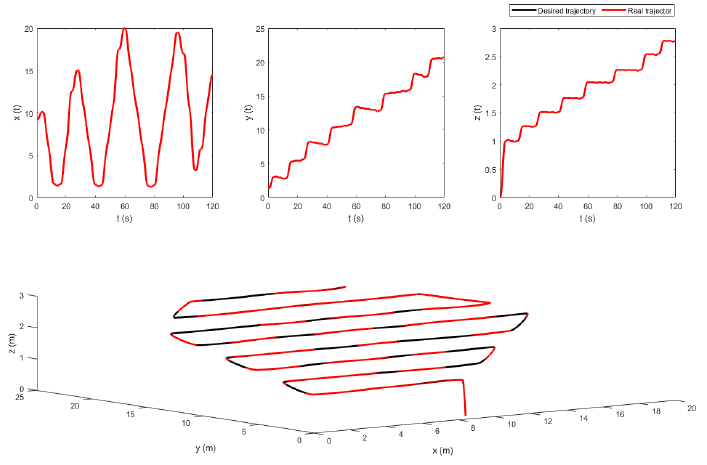
Figure 15. The tracking results of the flight in terrain 2.